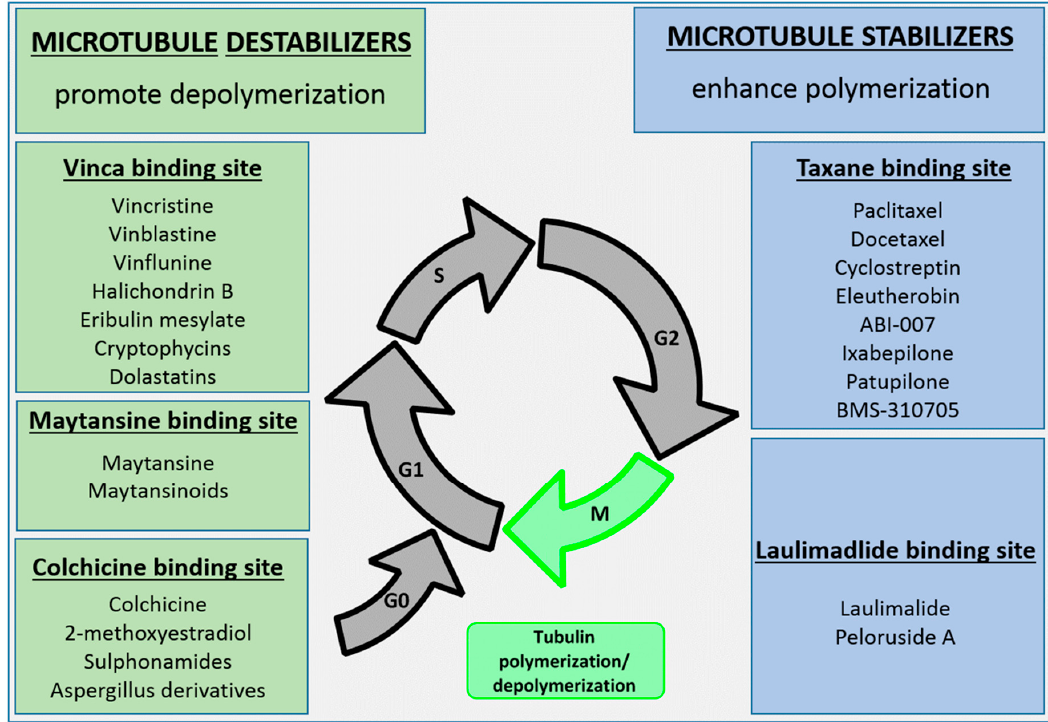
Figure 4. Classification of tubulin stabilizers and destabilizers arresting cell cycle at G 2 /M phase.